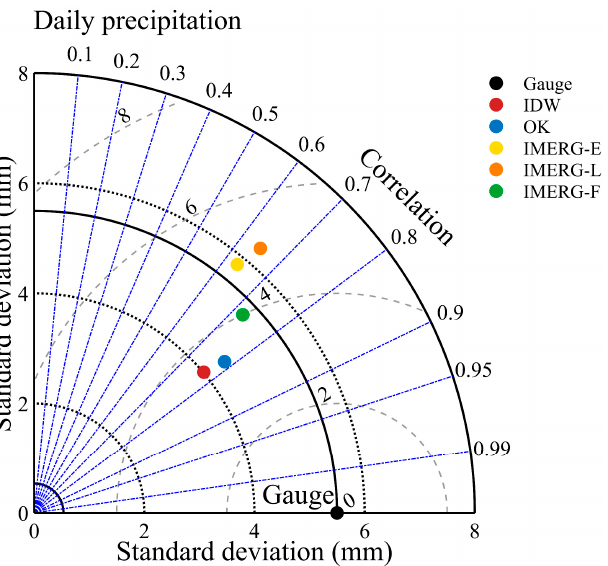
Figure 4. Taylor diagrams of the daily precipitation estimated from two interpolation methods and three IMERG SPPs in MRYRB from 1 January 2008 to 31 December 2019.